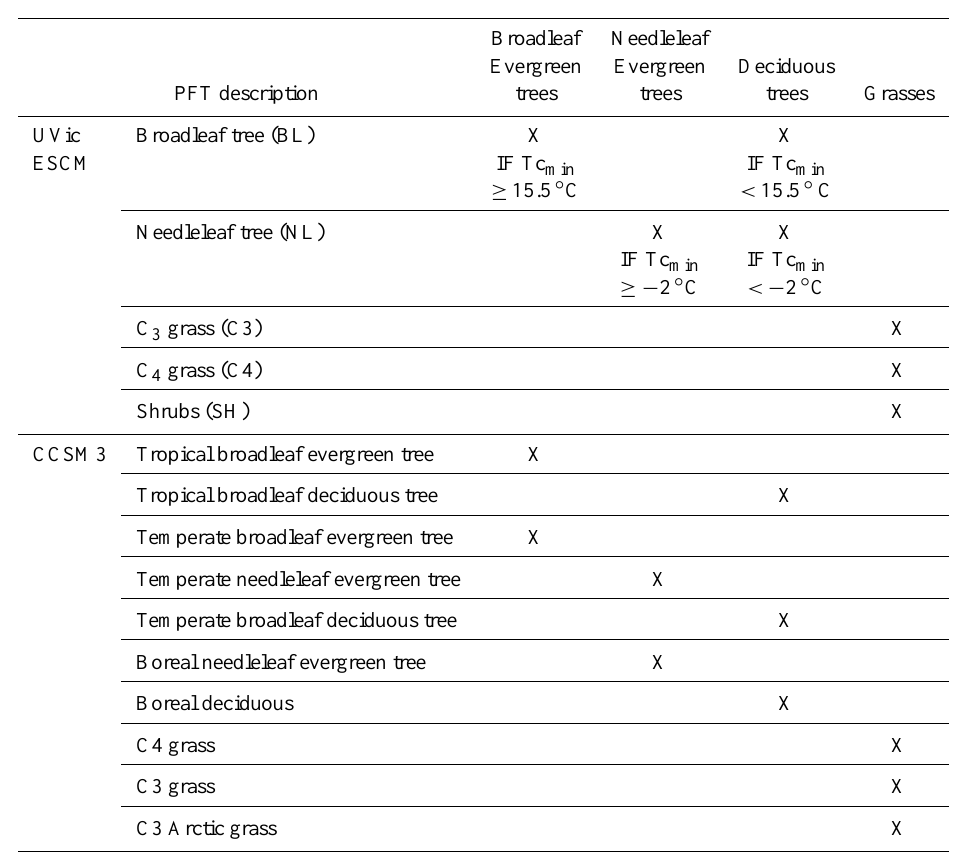
Boreal needleleaf evergreen